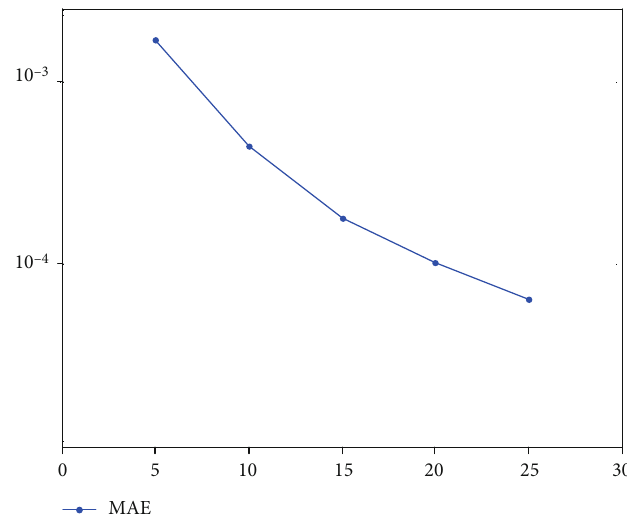
= N = N with N of Example 4 using ε = 0 : 1 . x x y t